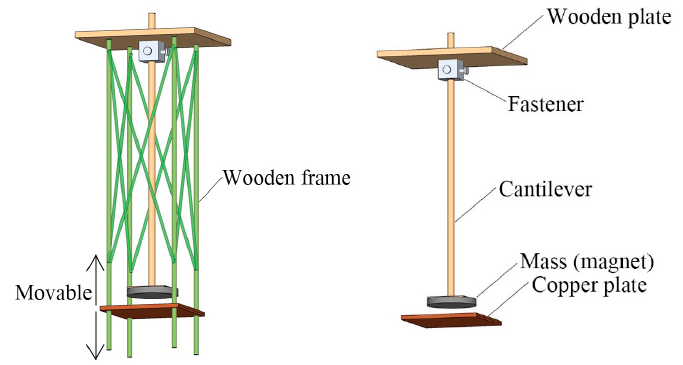
Figure 2. Schematic of ECTMD with and without exterior wooden frame.